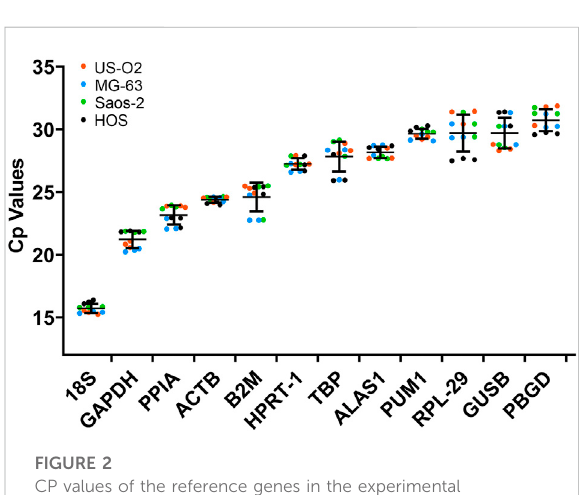
FIGURE 2 CP values of the reference genes in the experimental samples. Bars represent the mean ± standard